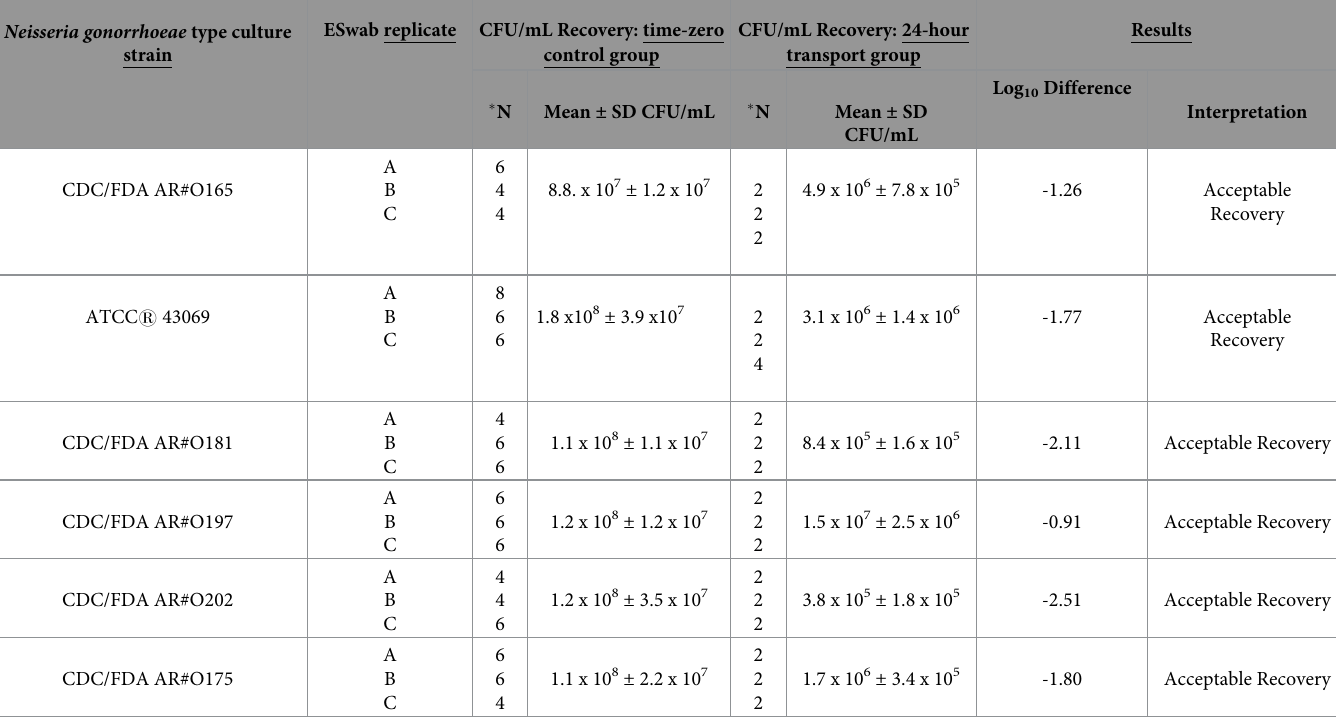
Table 2. Quantitative recovery results of the ESwab transport device for six Neisseria gonorrhoeae type culture strains. Neisseria gonorrhoeae type culture